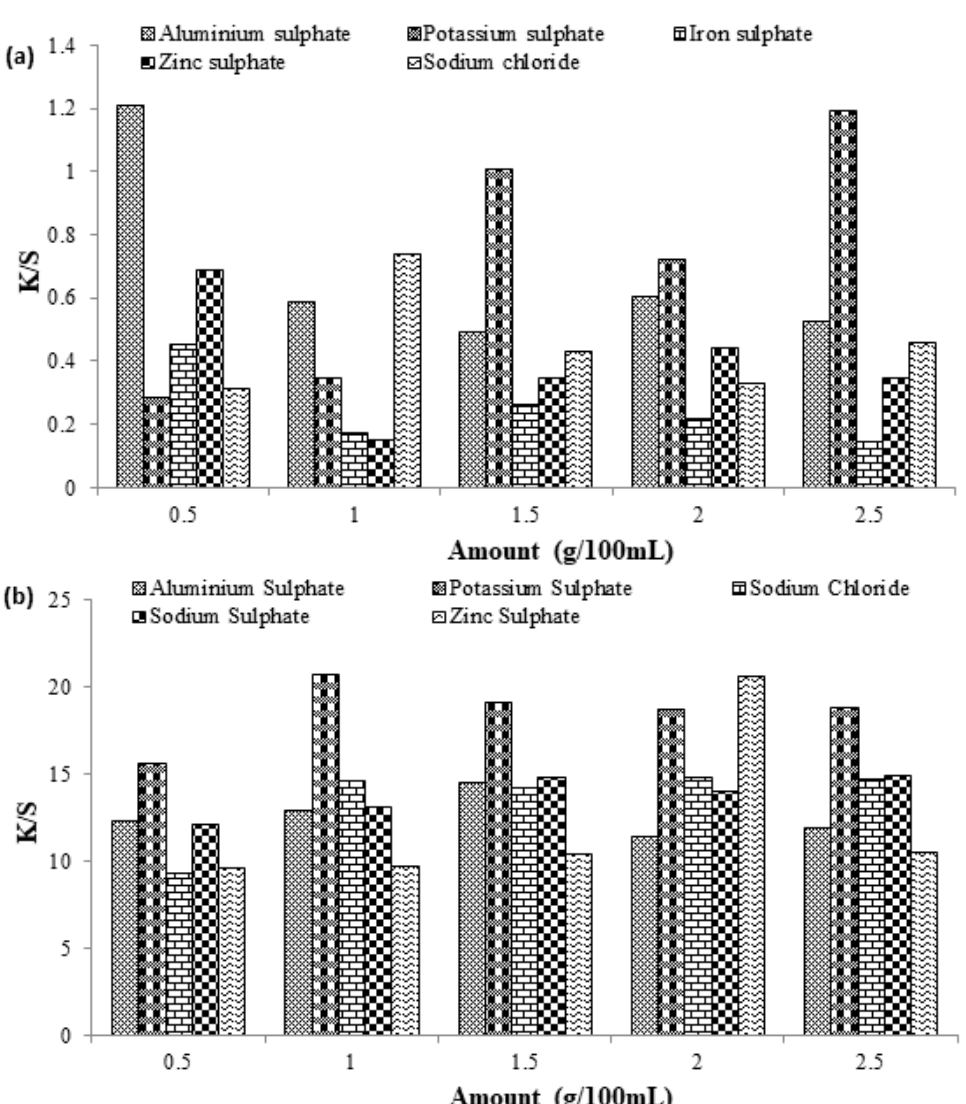
Figure 6. Effect of different salt concentrations on the dyeing behavior of cotton fabric dyed with ( a ) Reactive Violet 05 and ( b ) Direct Violet 09 dye.